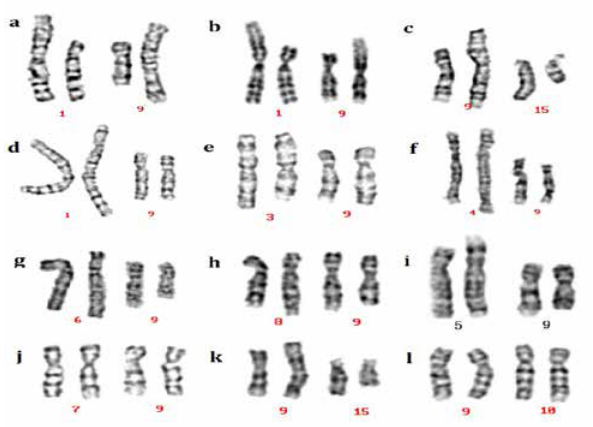
Figure 1: G-banding karyotypes of the 12 cases identified as